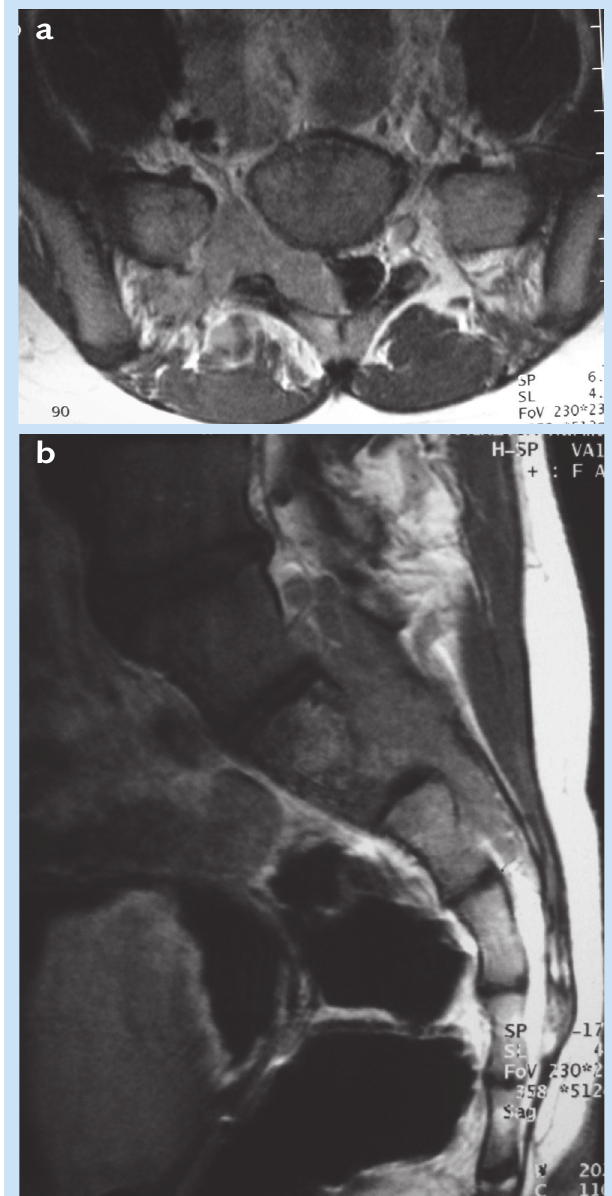
Fig. 2. An 11-year-old girl with Ewing’s sarcoma of the sacrum. Axial (a), and sagittal (b) T1-weighted gadolinium-enhanced images. Extradural extension of the iso-intense mass through the neural